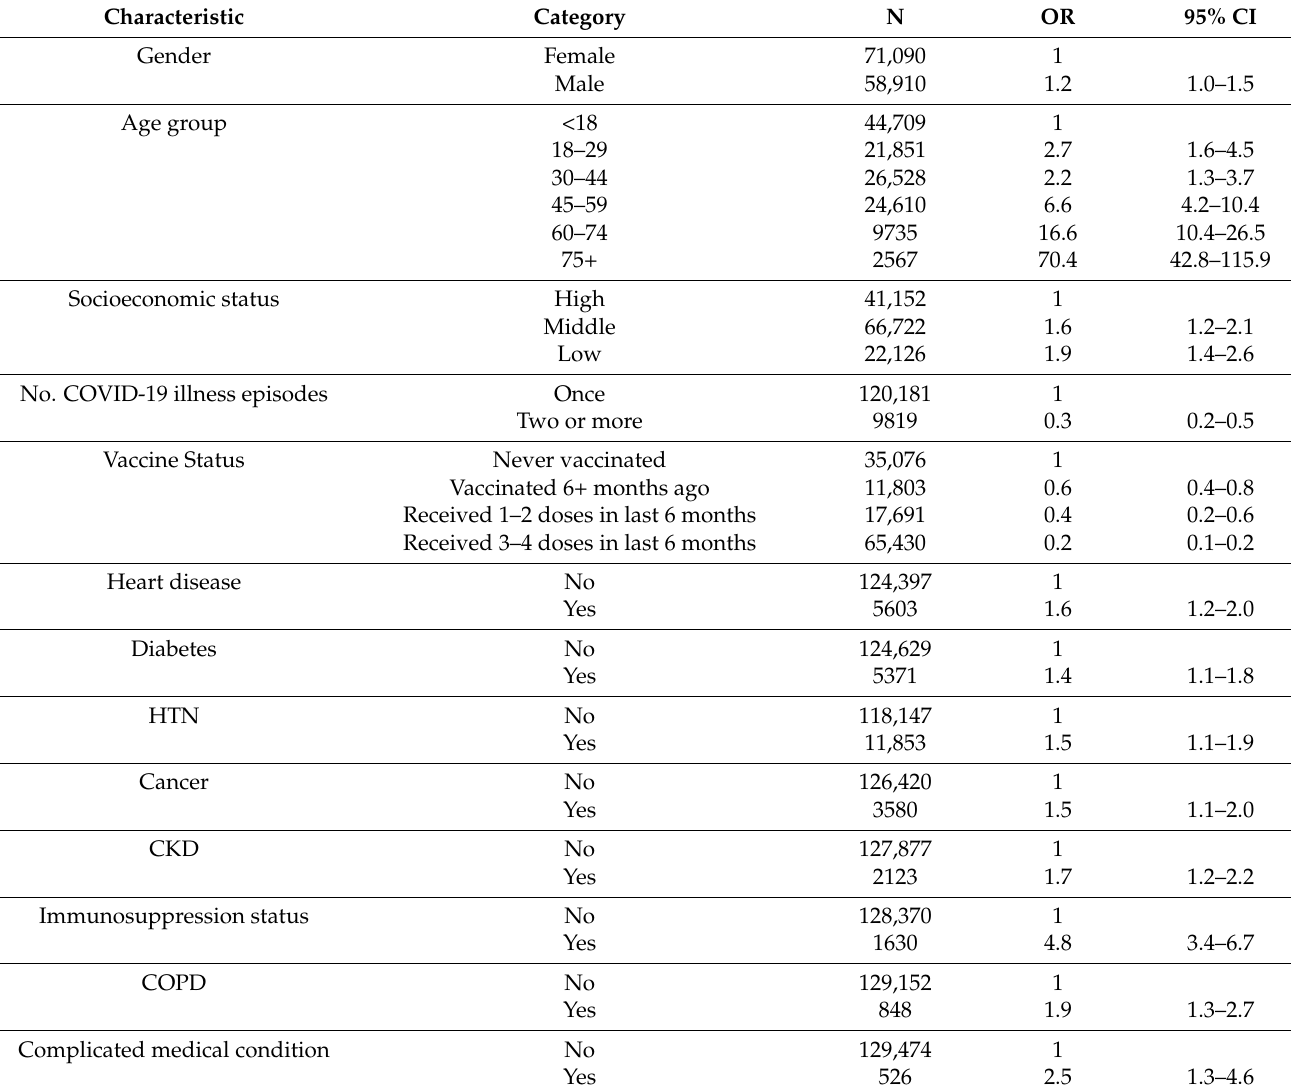
Table 2. Factors that were associated with severe illness (hospitalization or mortality) among